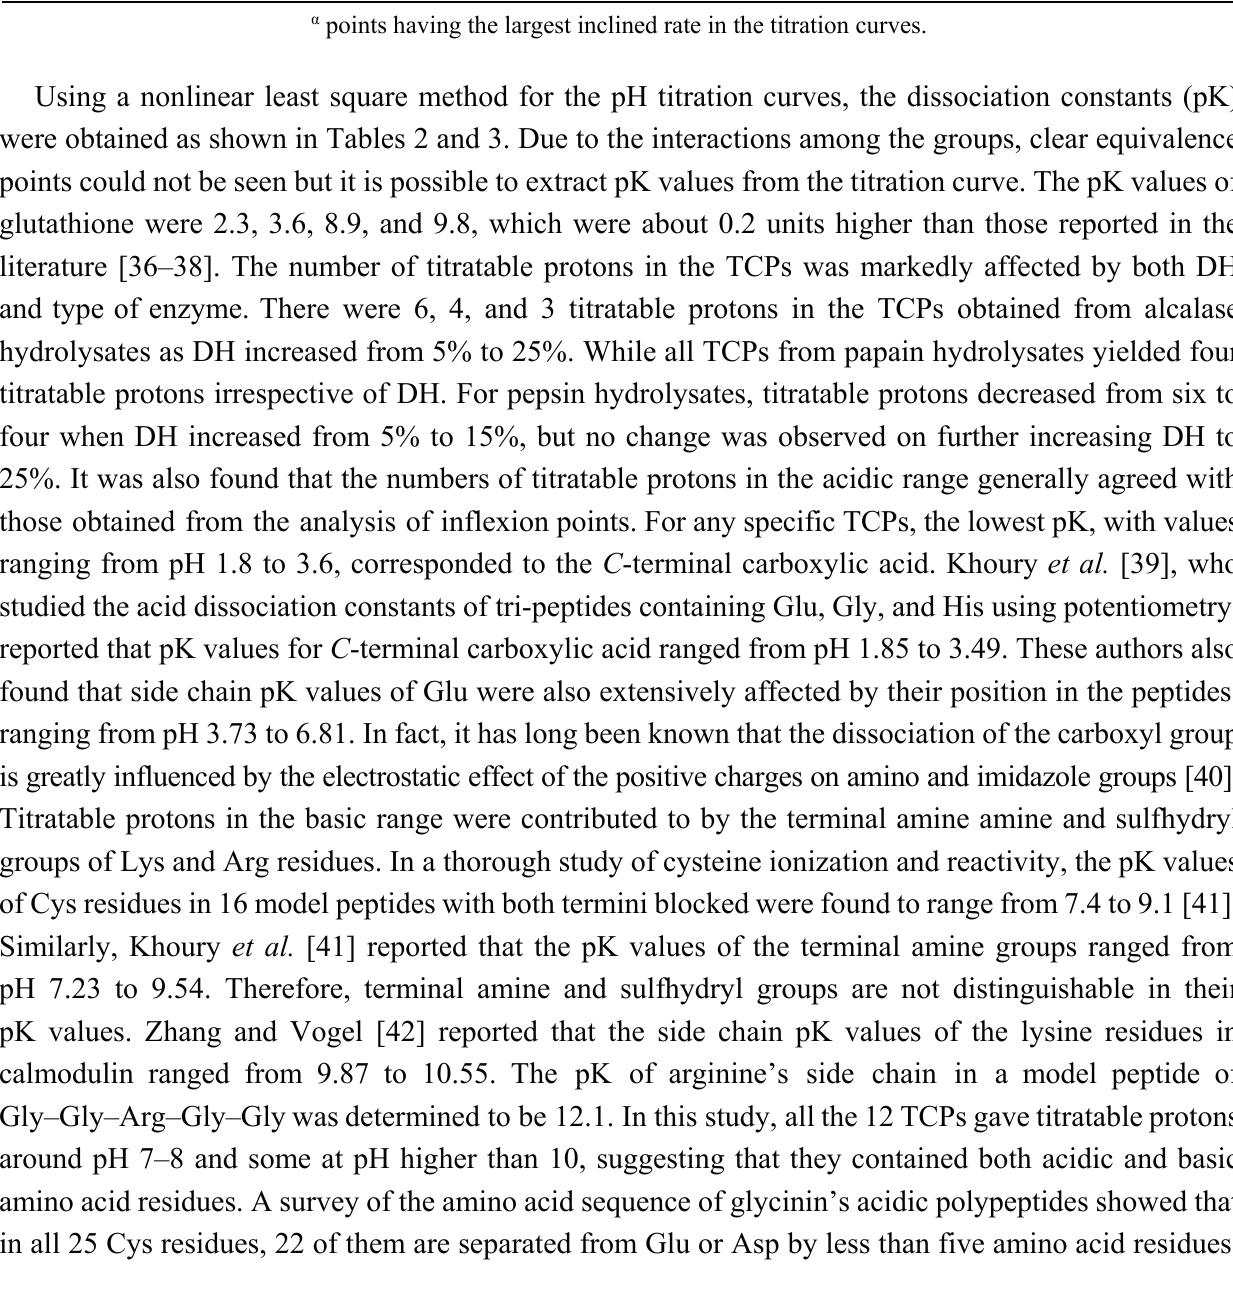
Table 1. Inflections α of titration curves of TCPs in the absence of metal ions. Hydrolysates Alc05 Alc15 Alc25 Pap05 Pap15 Pap25 Pep05 Pep15 Pep25 Concentration of KOH (mM) 22.0 18 14 18.2 18.8 20.0 22.0 18.0